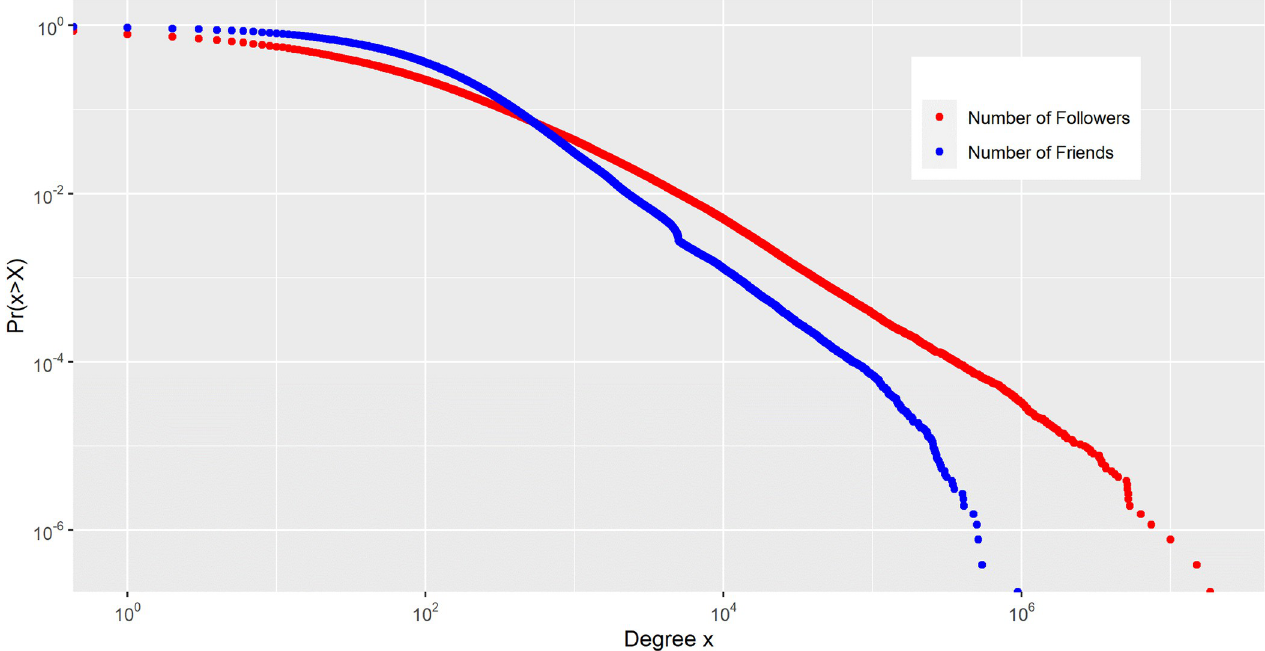
Fig 4. Log-log plot of the complementary cumulative distribution functions of the number of followers and number of friends.